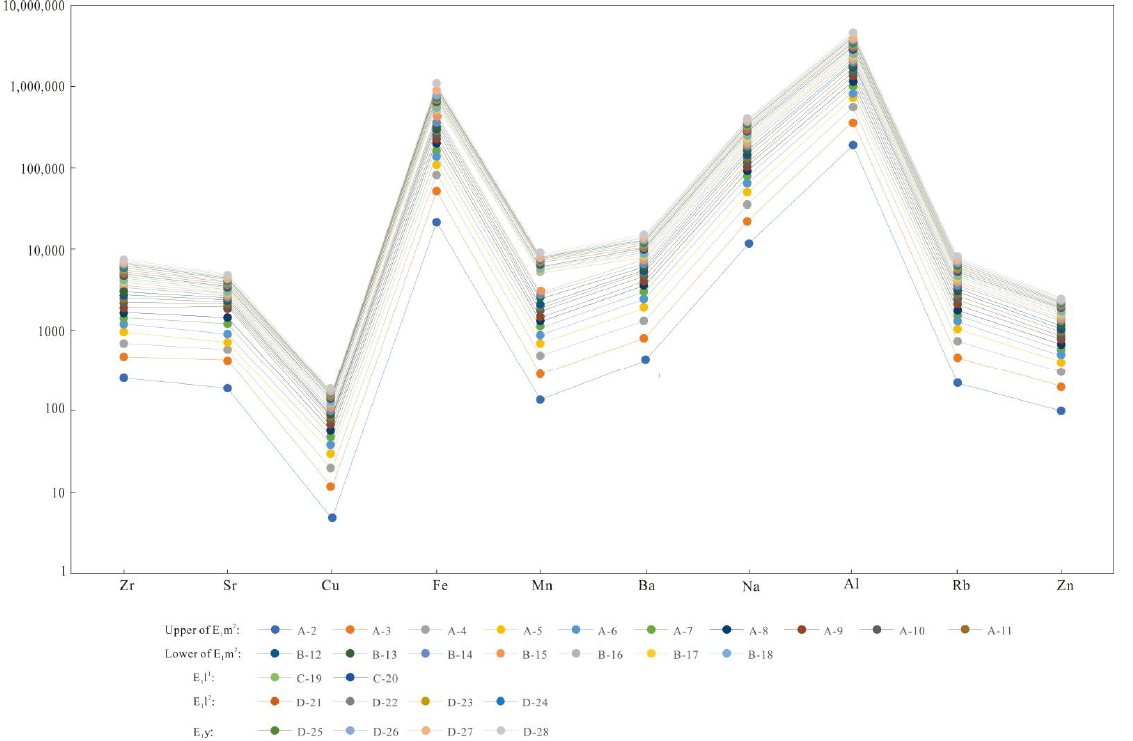
Table 2. The distribution of the major and trace elements of the Paleocene in the West Lishui Sag.